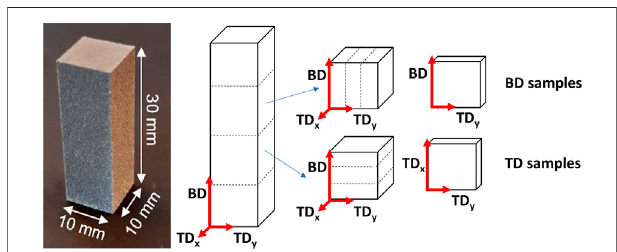
FIGURE 1 | Schematic of the cutting of the samples indicating build direction (BD) and transverse directions (TD), as well as the denomination used for the surfaces throughout the